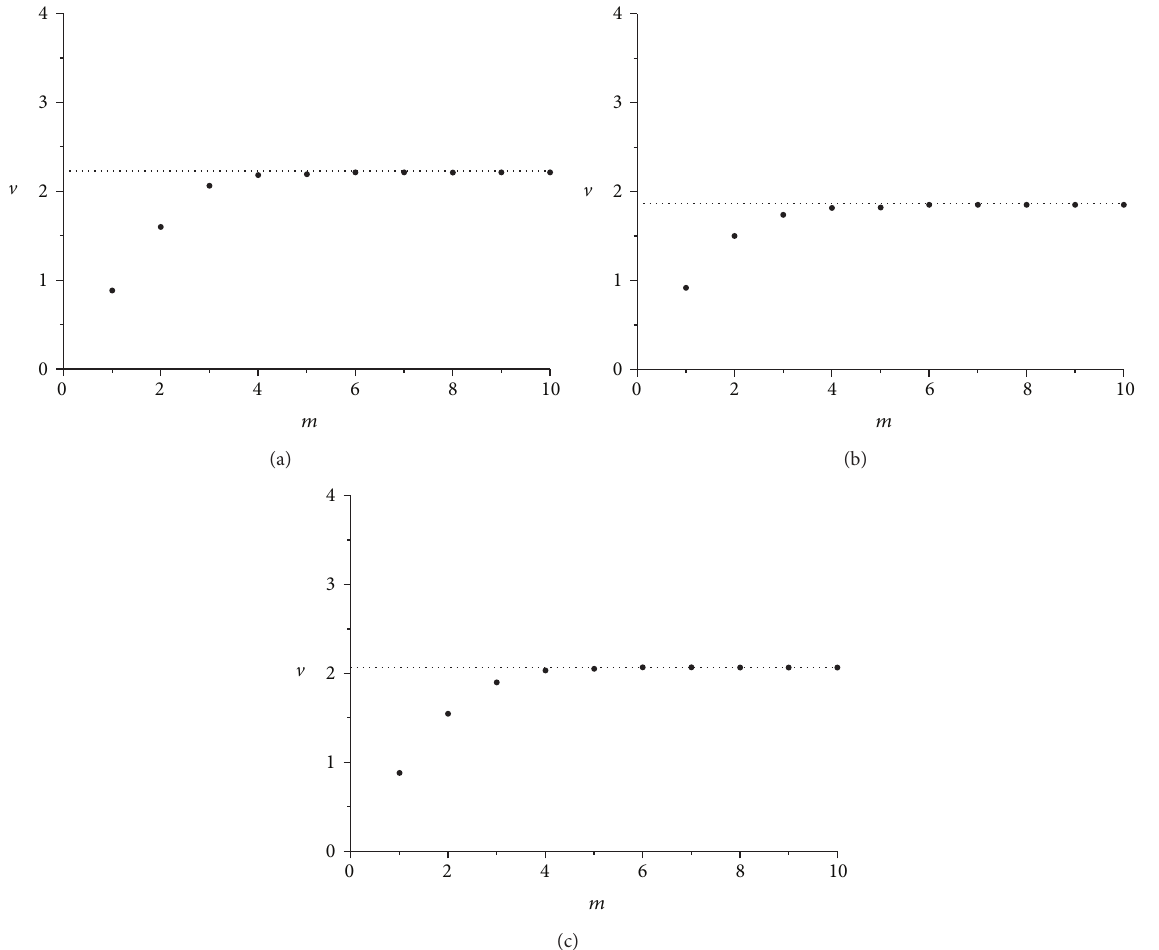
Figure 14: Correlation dimension V versus 𝑚 embedding dimension for angle 𝛿(𝑡) time-series in the cases of (a) wax, V = 2.20 , (b) gypsum, V = 1.85 , and (c) lead solder, V = 2.06 . Minimum embedding dimension is not the same in all cases, revealing the not so common dynamics of